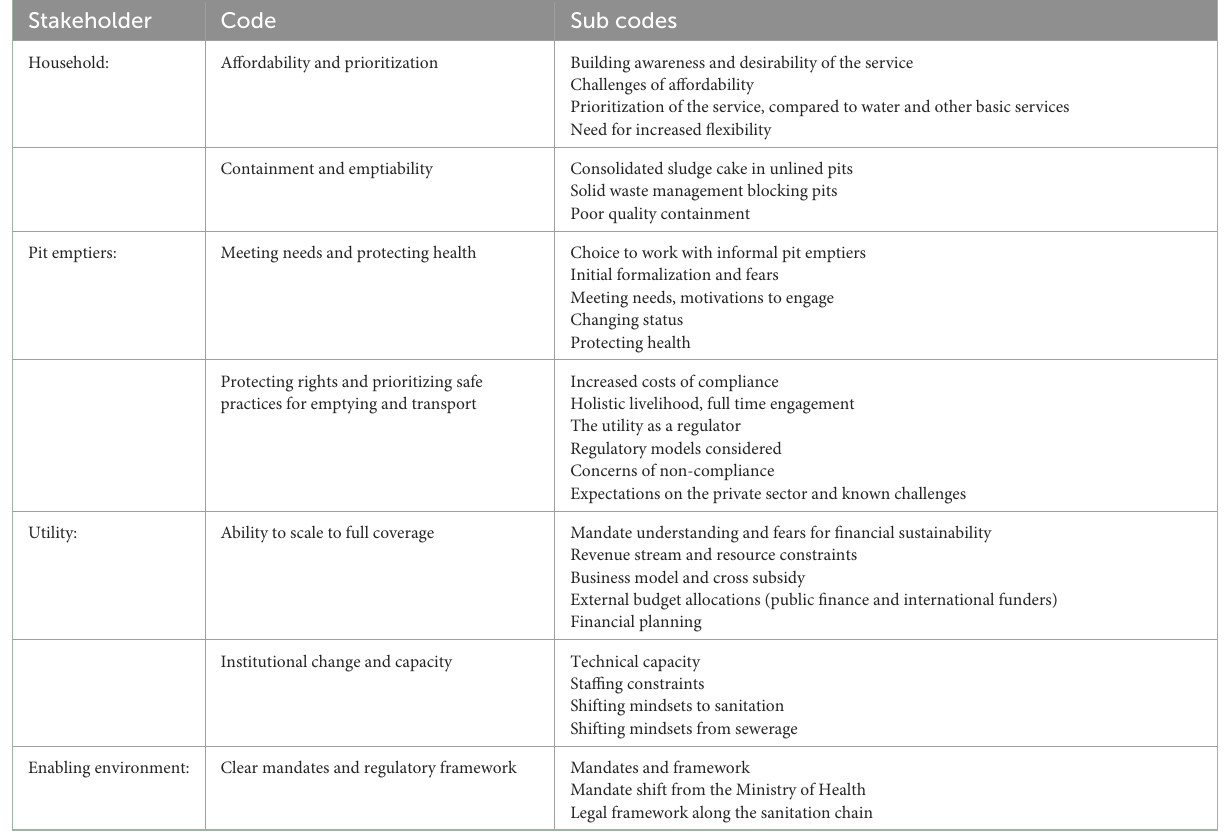
TABLE 3 Summary of final coding